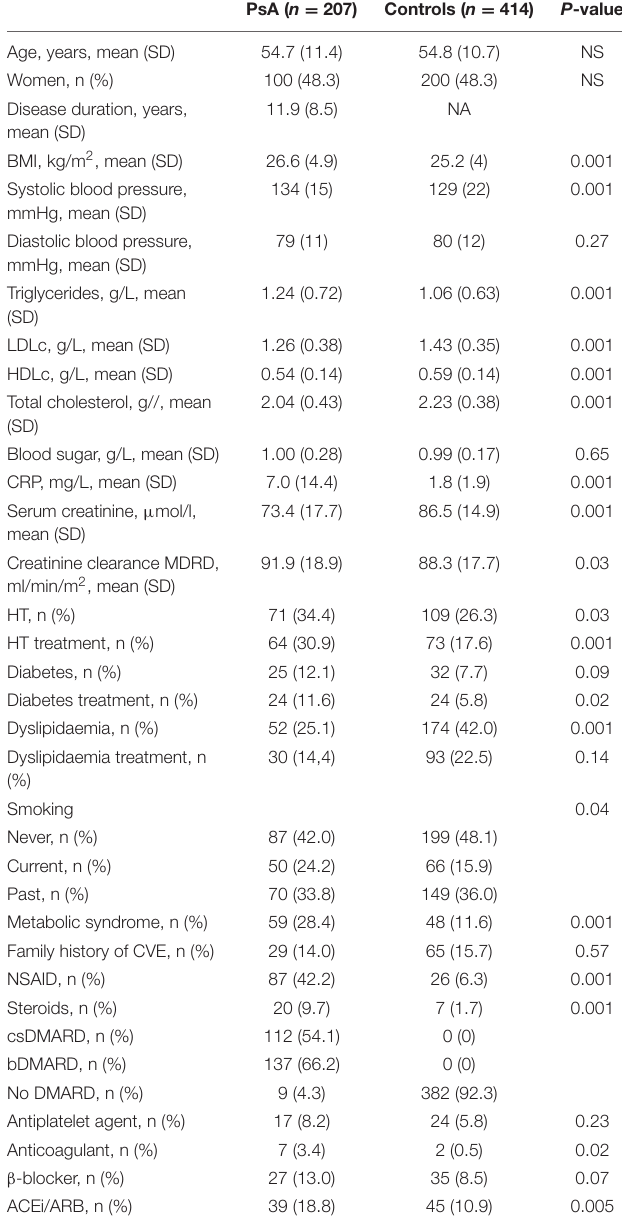
TABLE 1 | Characteristics of patients with psoriatic arthritis (PsA) and